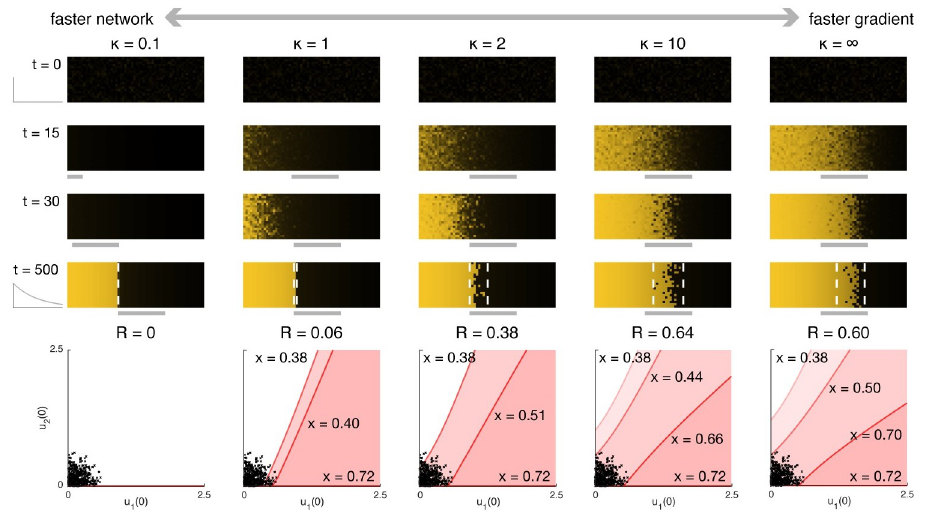
Fig 2. The precision of a gene expression boundary forming atop a dynamically growing gradient depends on the relative rates at which the network and the gradient evolve. The control (static gradient) corresponds to κ = 1 . Top, time lapses illustrating the concentration of u 1 across a whole embryo. Assuming the gradient emerges from a uniformly monostable state (here with α ( t = 0, x ) = 0), then the slower the gradient emerges, the more precise the resulting boundary will be. Boundary formation lags the movement of the bistable region from anterior to posterior. Bottom, the width of the imprecise region can be predicted from the basins of attraction at each coordinate x ; see Fig 1. R quantifies the maximum width of the imprecise region (which depends on the initial conditions) relative to the width of the bistable region, with lower R indicating higher precision. That R is higher for κ = 10 relative to κ = 1 is an artifact of the particular choice of initial conditions, which are shared across all simulations pictured